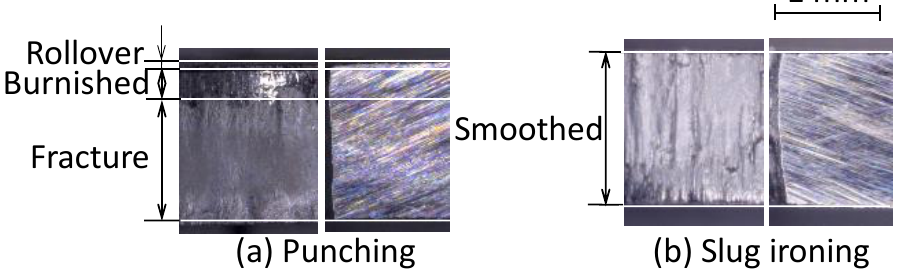
Figure 8. Surfaces and cross-sections of edges ( a ) without and ( b ) with slug ironing for punched 1500 MPa ultra-high strength steel sheet of 10% clearance ratio [52].